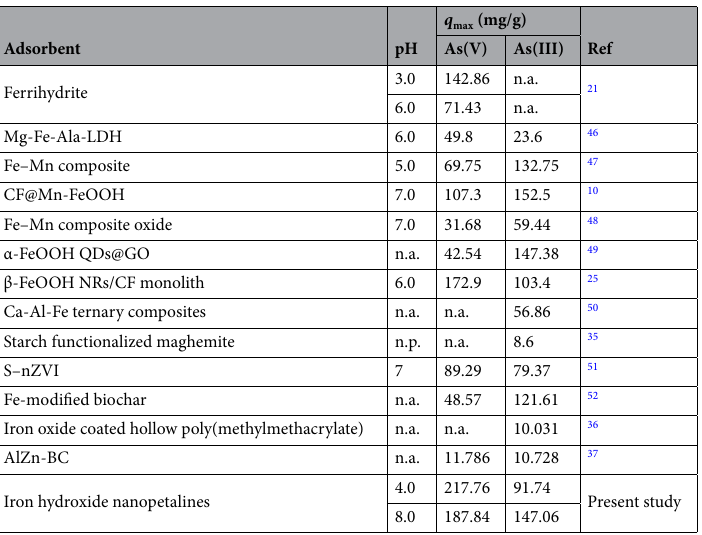
Table 4. Comparison of the maximum As(V) and As(III) adsorption capacities of various iron hydroxides. n.a. not available, n.p. neutral